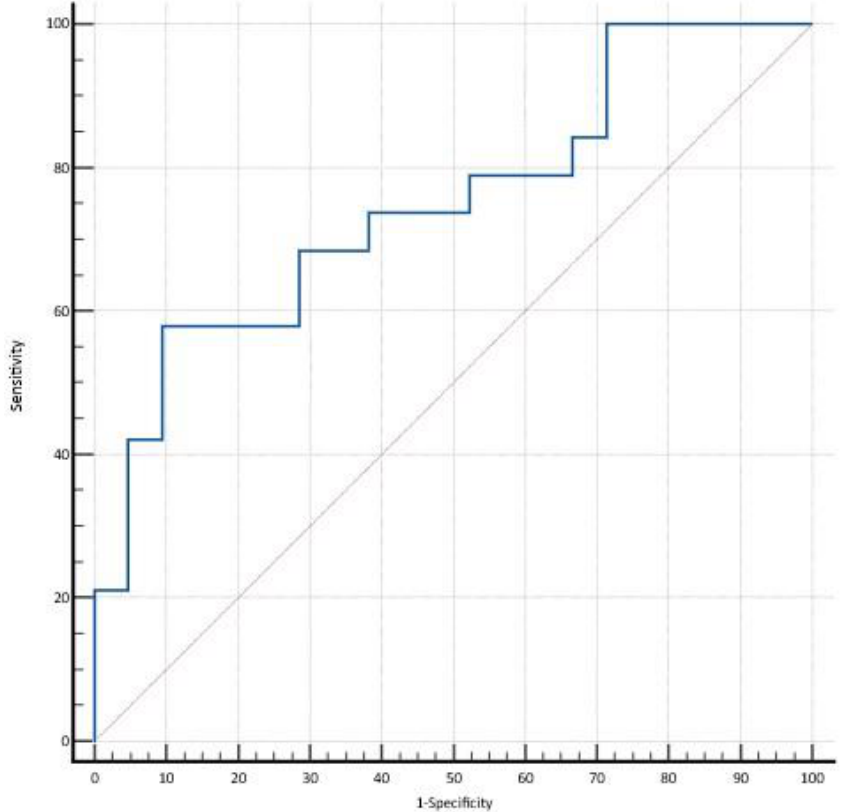
Figure 3. ROC curve analysis of theta relative power performed on Global PSD of TEA and TGA patients.